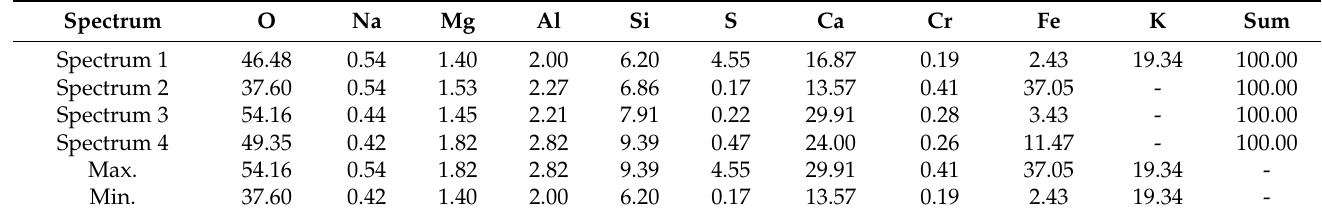
Table 4. Composition of the spent sorbent after wastewater treatment.